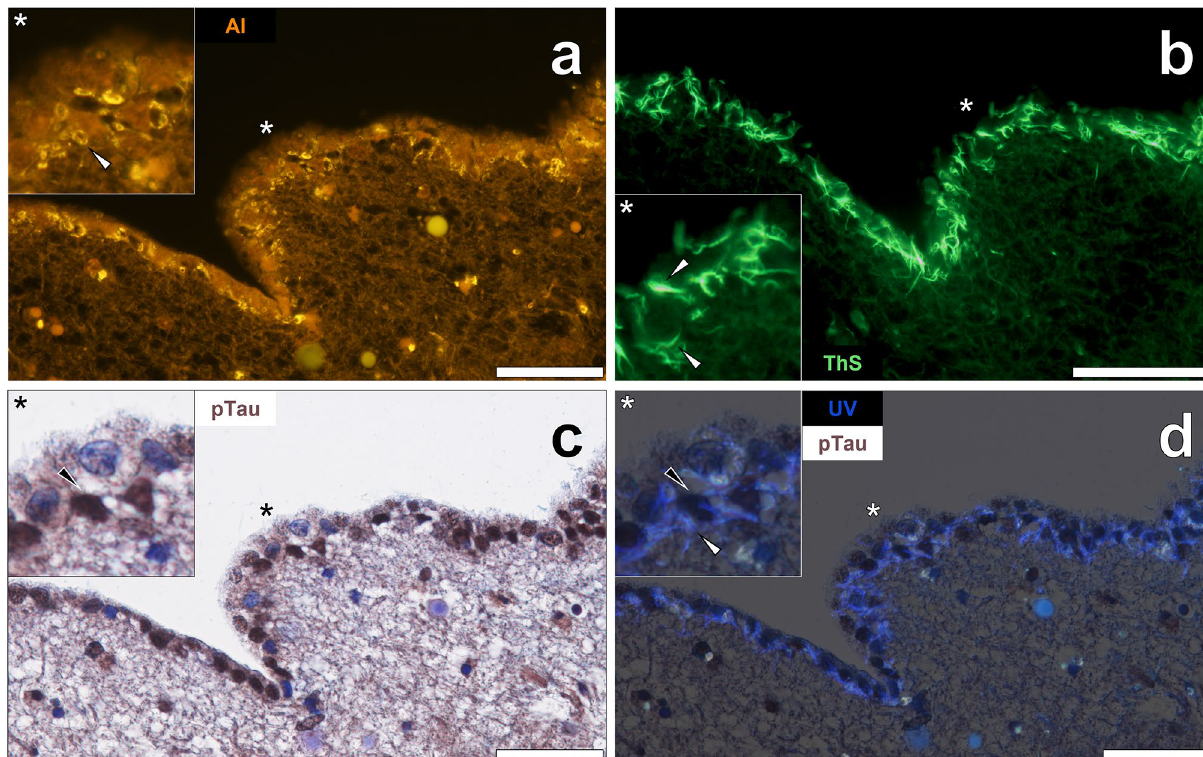
Figure 6. Aluminium is co-deposited with thioflavin S (ThS) reactive Biondi tangles in ependymal cells of a 76-year-old female donor with Parkinson’s disease. ( a ) Aluminium (Al) fluorescence was observed in ependymal cells of pia mater lining the lateral ventricle with intense orange/yellow fluorescence in Biondi ring tangles (white arrows). ( b ) Cytoplasmic ThS-reactive Biondi ring tangles were identified in ependymal cells in an adjacent section. ( c ) DAB immunolabelling (black arrows) of phosphorylated tau (pTau) in identical ependymal cell nuclei. ( d ) Merging of the brightfield channel with UV induced autofluorescence demonstrated proteinaceous Biondi tangles in cell cytosol with pTau localised to cell nuclei. Asterisks denote magnified inserts. Magnification: × 400, scale bars: 50